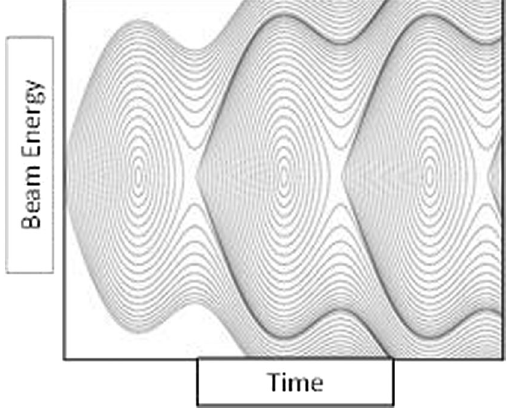
FIG. 7. Phase space trajectories of rf “ buckets ”